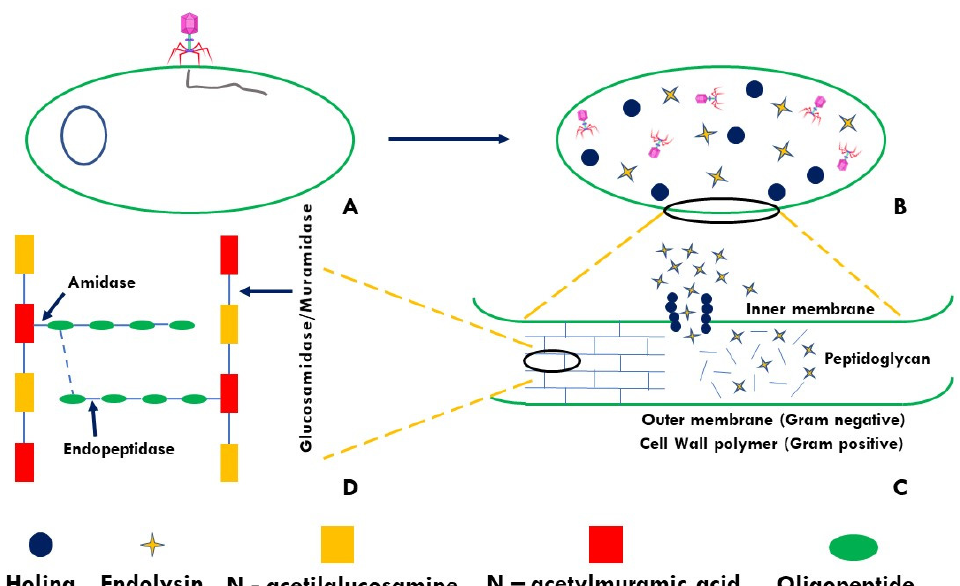
Figure 2. Mechanism of alteration of peptidoglycan (PG) by the endolysin-holin system: ( A ) Infection by bacteriophage; ( B ) Lysis of bacterial cells; ( C ) Endolysin-holin mediated PG disruption; ( D ) Endolysin sites of action.